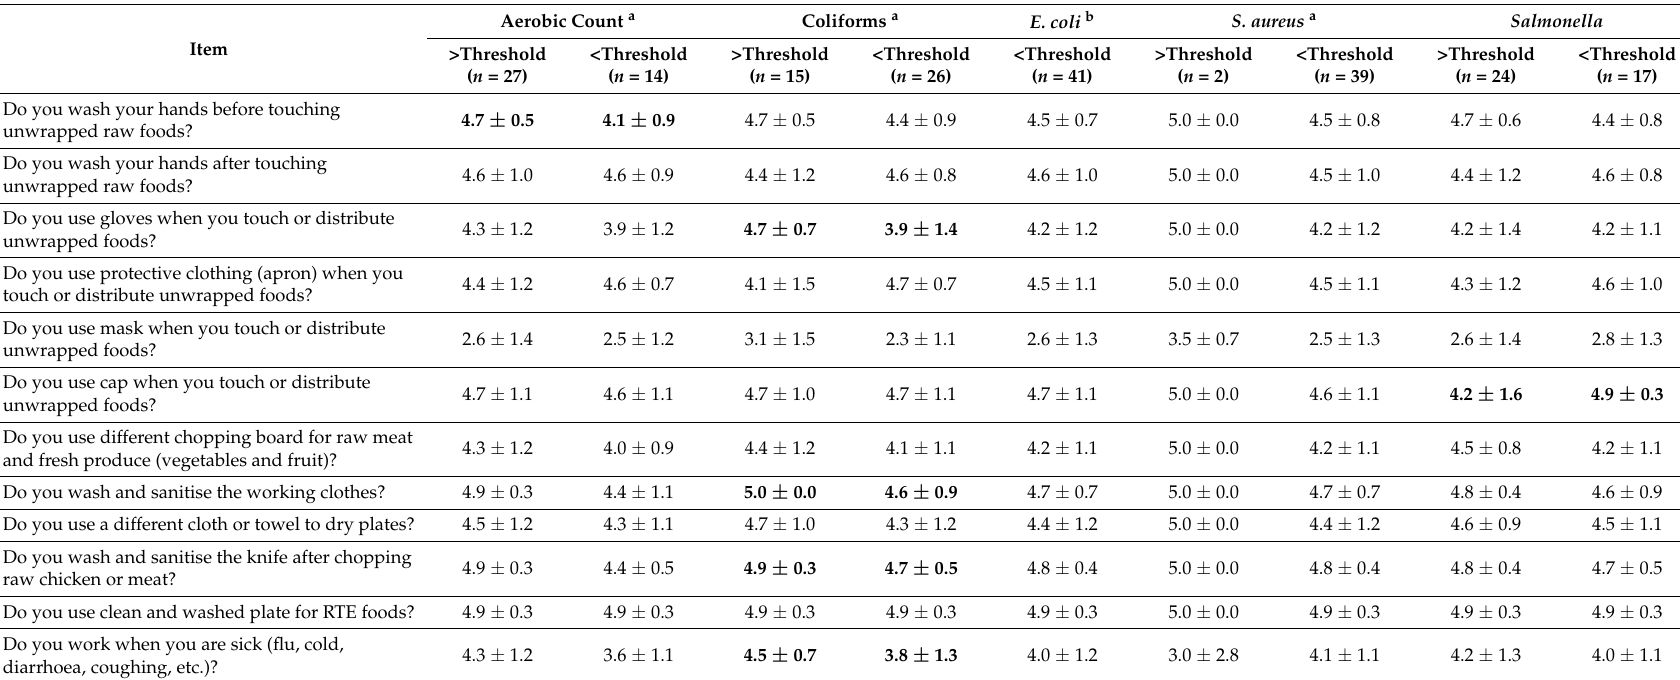
Table 6. Self-reported practices vs. microbial contamination on food handlers’